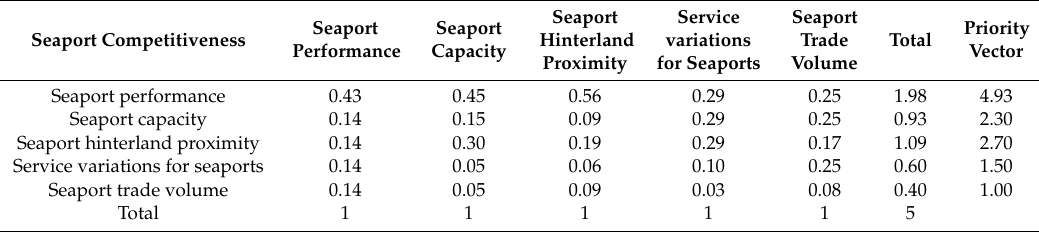
Table 9. Normalization test of port competitiveness criteria